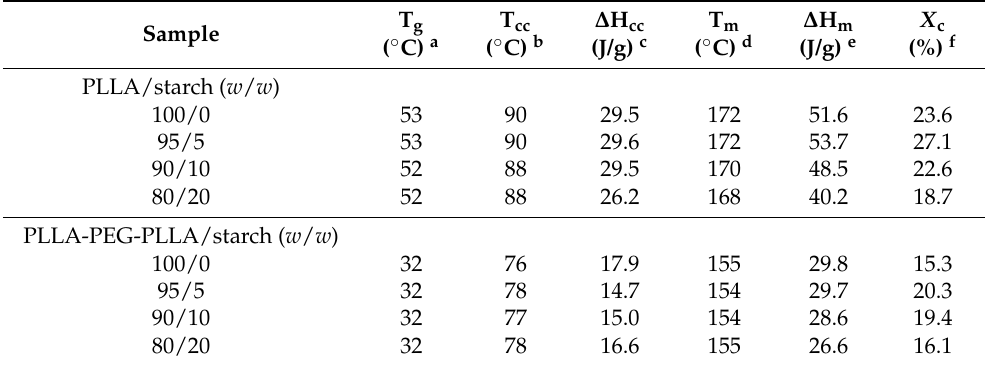
Figure 2. DSC heating curves of ( above ) PLLA/starch and ( below ) PLLA-PEG-PLLA/starch compo- sites with blend ratios of ( a ) 100/0, ( b ) 95/5, ( c ) 90/10 and ( d ) 80/20 ( w/w ). Table 1. Thermal transition properties of PLLA/starch and PLLA-PEG-PLLA/starch composites obtained from DSC heating curves in Figure